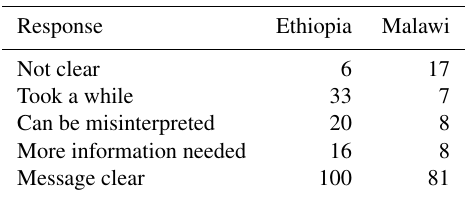
Table A2. A subtable showing how many individuals selected a given response to Q1 when columns are pooled within the location of the meeting. Table A3. Responses to Q5 pooled responses from the Ethiopia and Malawi